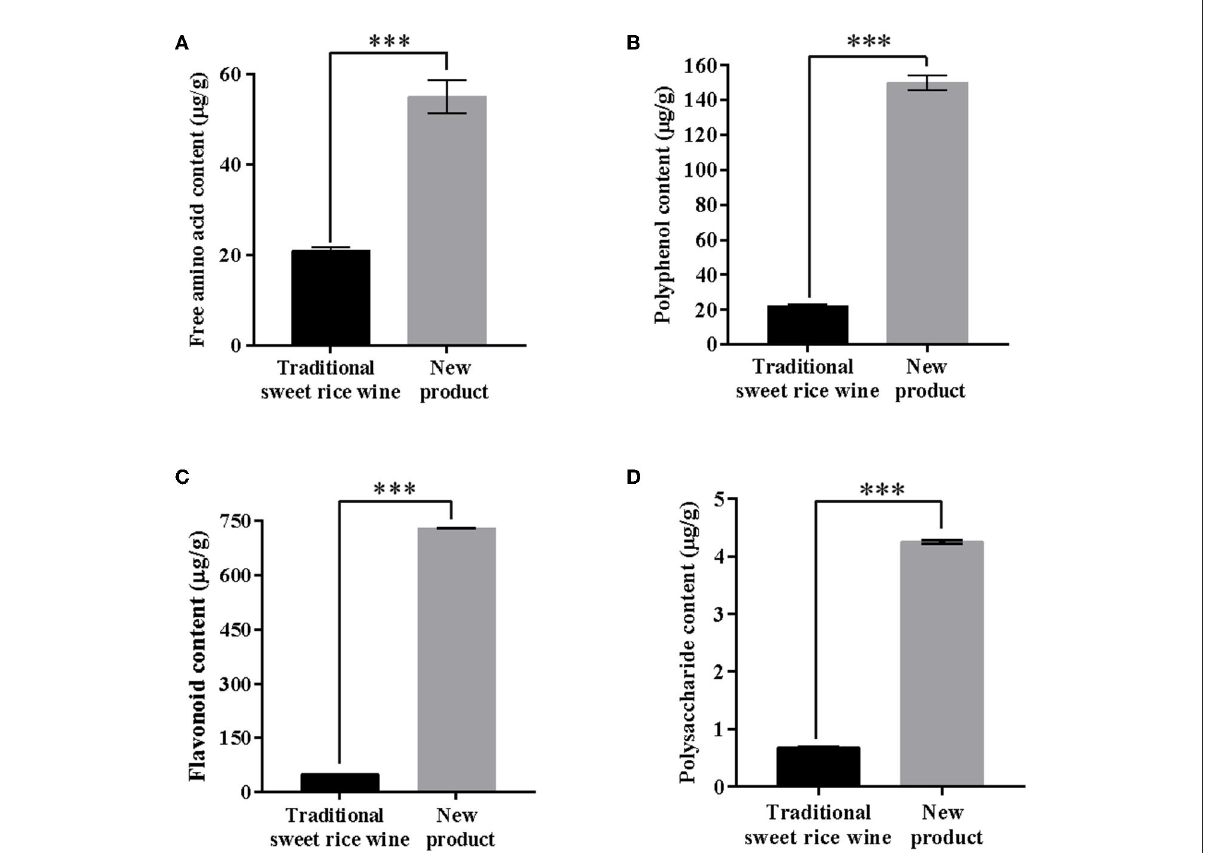
FIGURE4 Analysis of the content of main nutrients in the new product and traditional sweet rice wine. (A) Free amino acid content; (B) polyphenol content; (C) flavonoid content; (D) polysaccharide content ( n = 3). *** p < 0.001.